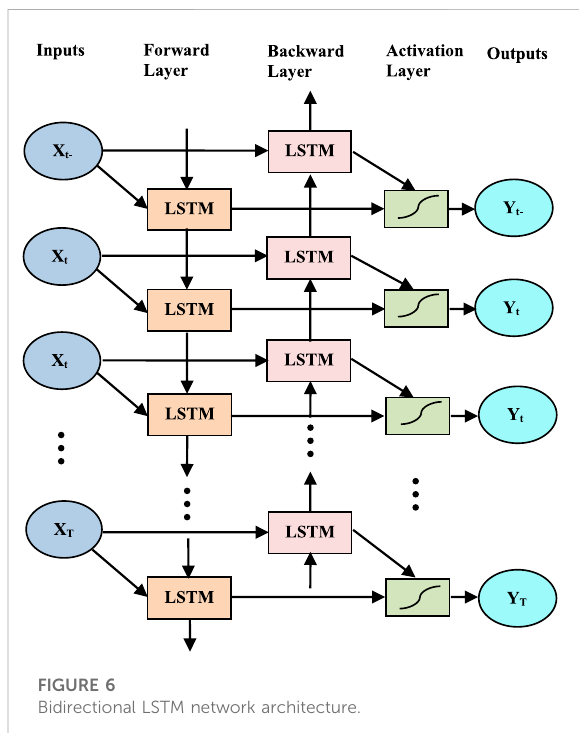
FIGURE 6 Bidirectional LSTM network architecture.